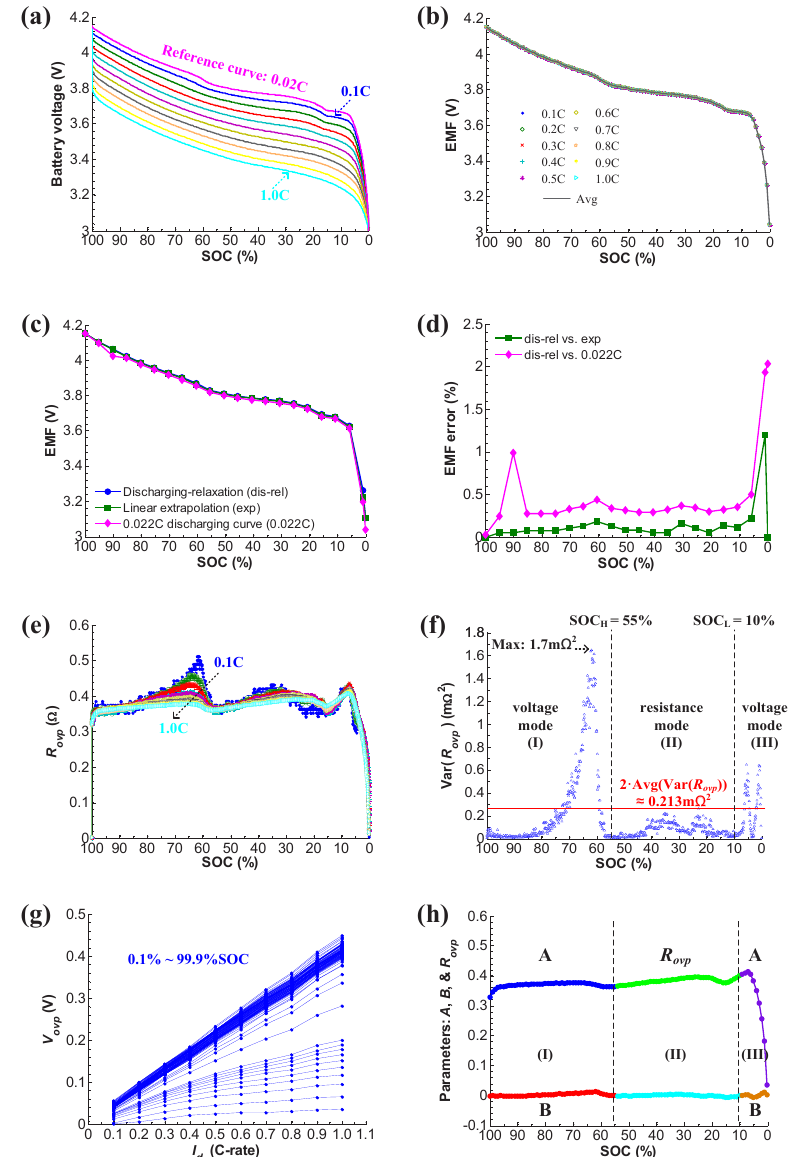
Figure 11. Experimental results of parameter extraction: ( a ) battery voltage-SOC curves; ( b ) EMF-SOC curves; ( c ) EMF comparisons; ( d ) EMF errors; ( e ) R ovp -SOC curves; ( f ) variance of R ovp ; ( g ) V ovp - I d curves; ( h ) parameters: A , B and R ovp